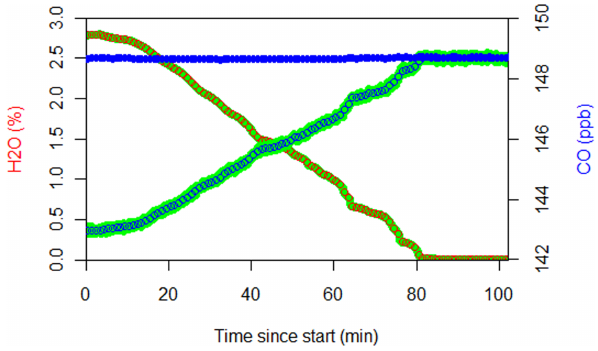
Fig. 8. Example of CO and H 2 O time series during the water vapour interference experiment with the ICOS-QCL analyser. Green cir- cles are 1-s raw data, open circles are 1-min averages. The filled blue circles are water vapour-corrected 1-min CO data based on this experiment.